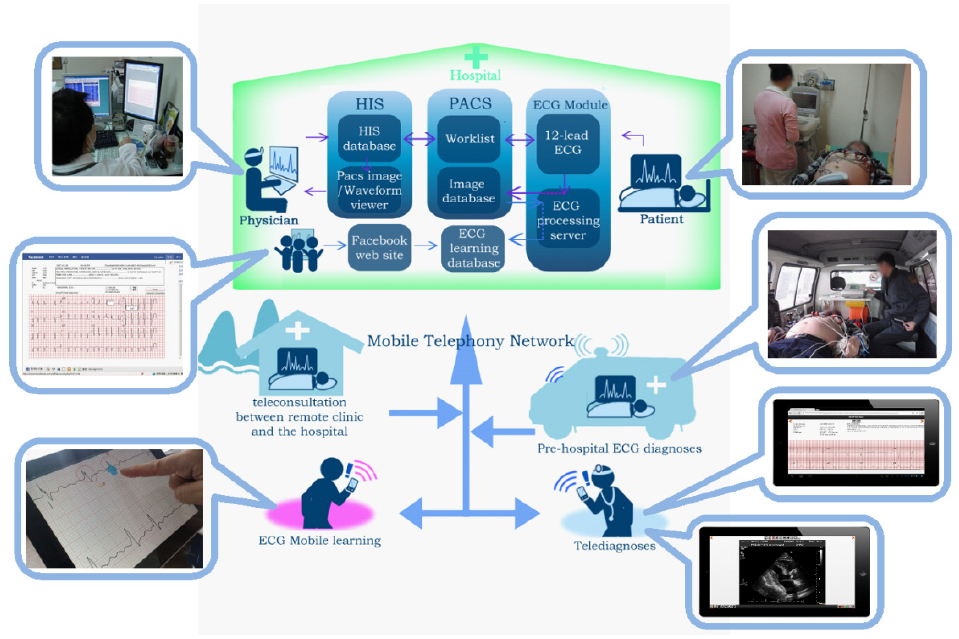
Figure 4. Mobile computing based